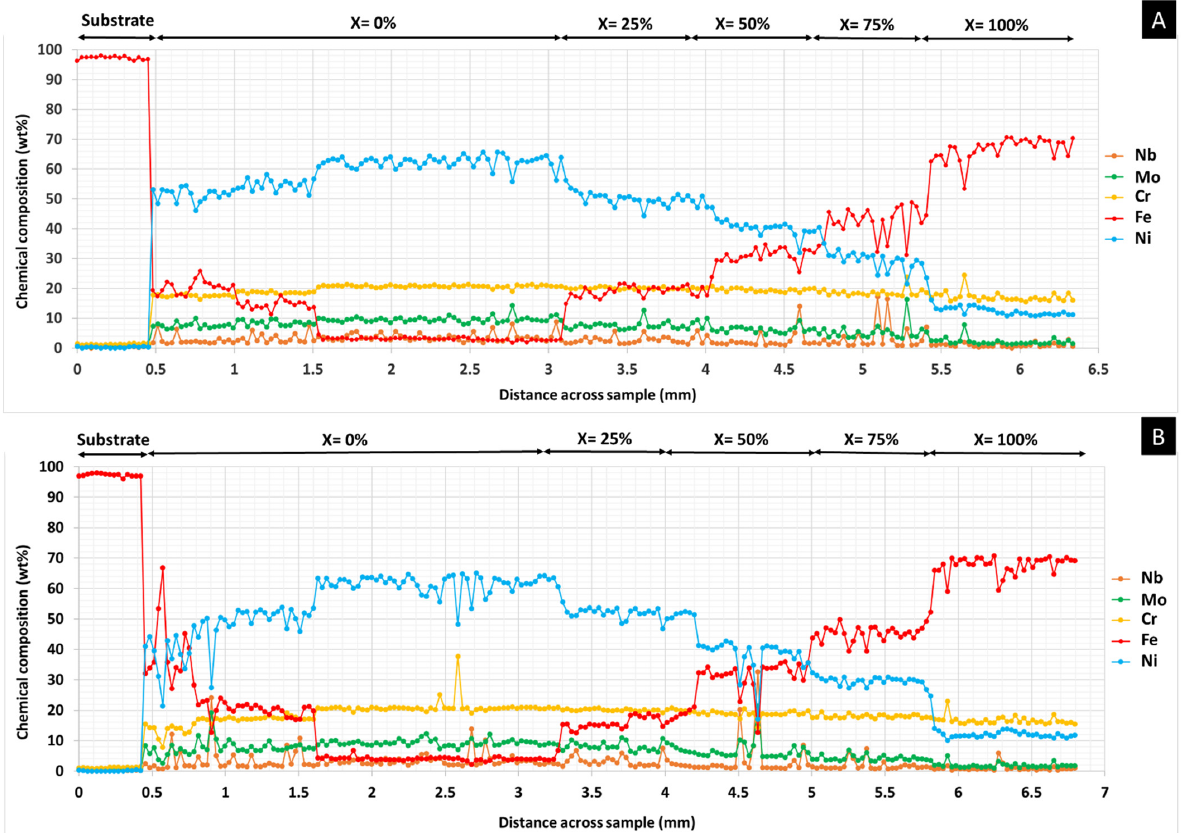
Figure 5. FGM linear chemical analysis—( A ) without PHT and ( B ) with PHT. The composition of each FGM zone is (100-X)% M625 + X% M42C.